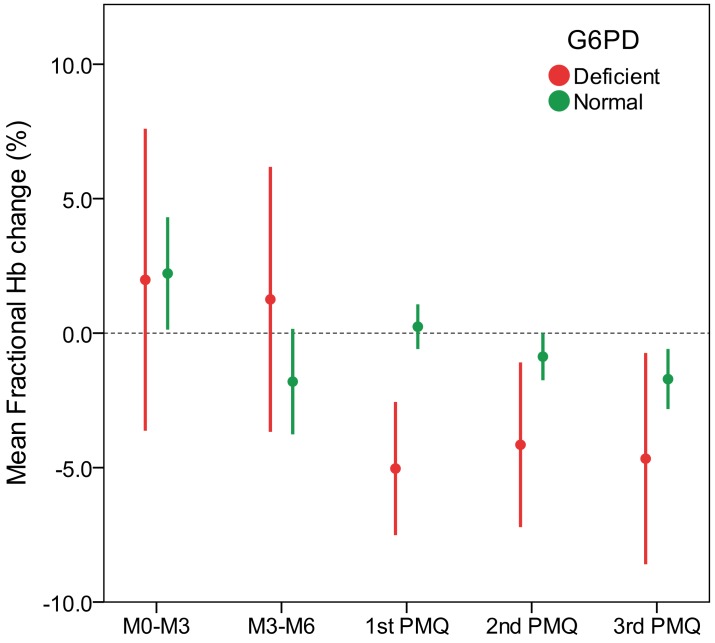
Mean and 95%CI fractional haemoglobin changes by G6PD phenotype.Only subjects who participated to the PMQ treatment rounds were included in the M0-M3 and M3-M6 analysis. In the PMQ rounds, data points of subjects with haemoglobin checked outside the 5–8 days post-treatment range were excluded from analysis. PMQ = primaquine, Hb = haemoglobin concentration.